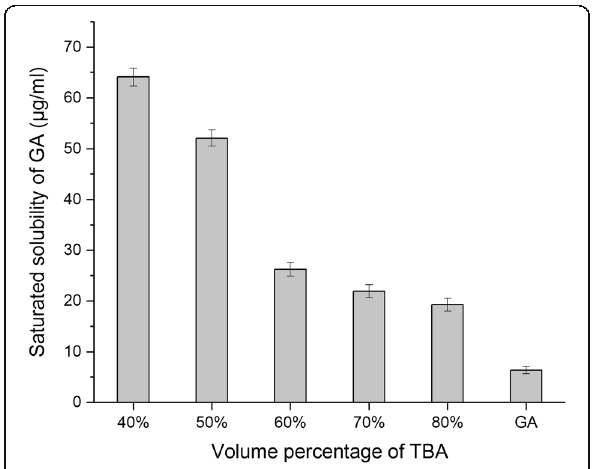
Fig. 7 Aqueous solubility of GA lyophilization in TBA/water co- solvent with different volume percentage (mean ± SD, n =